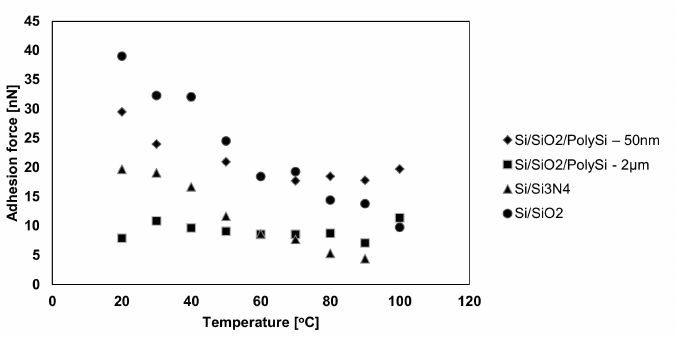
Figure 31. Adhesion force versus temperature for Si/SiO 2 , Si/Si 3 N 4 , Si/SiO 2 /PolySi—2 µ m, Si/SiO 2 /PolySi—50